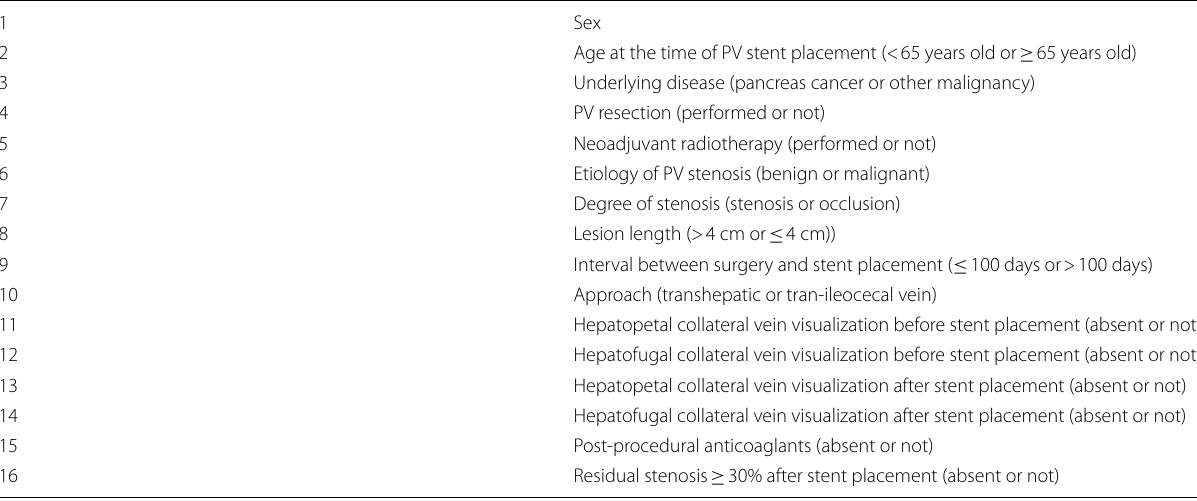
Table 1 Sixteen variables examined association with PV stent occlusion. (Location: After the sub-heading “Definitions and data collection” in the Materials and